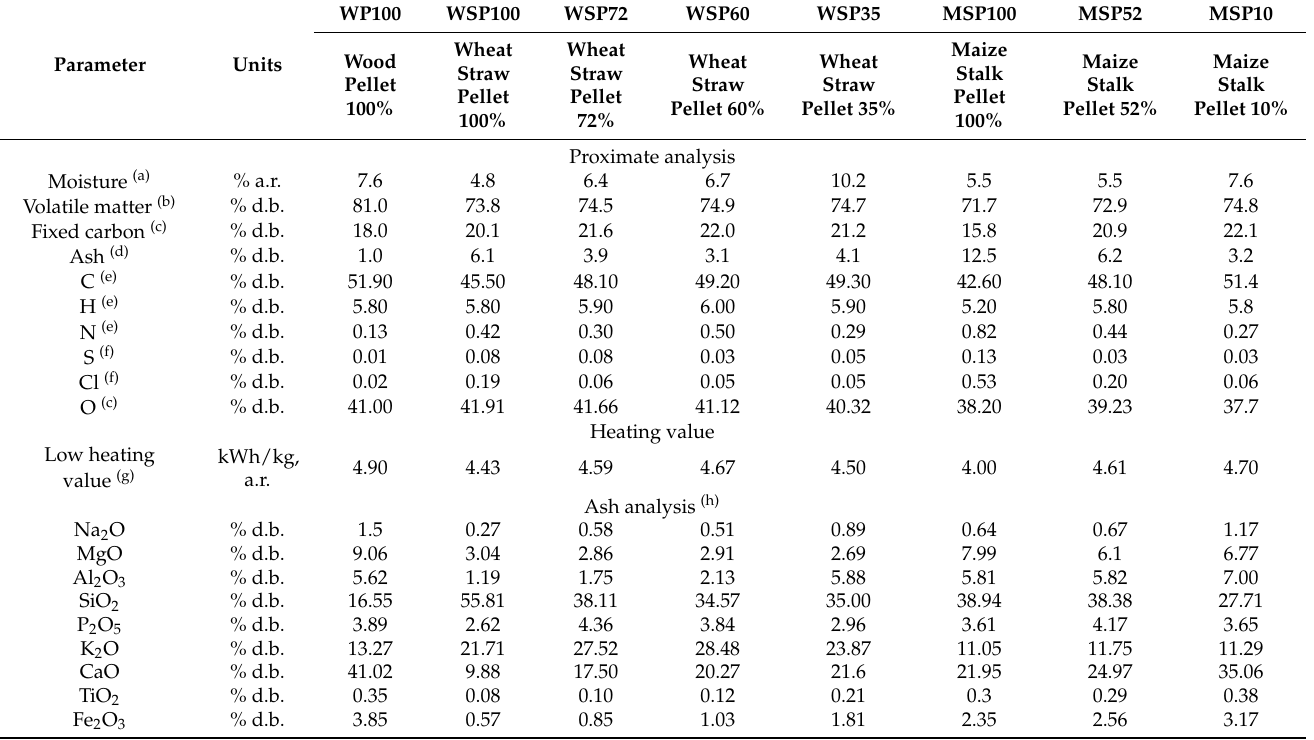
Table 1. Fuel properties (% a.r.: weight percentage as received; % d.b.: weight percentage in dry